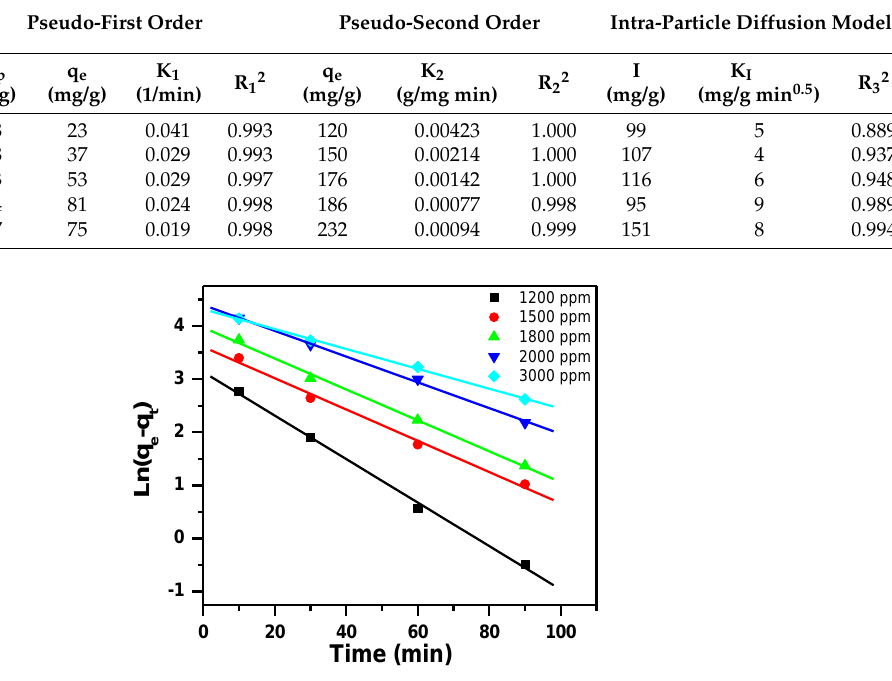
Figure 8. Pseudo-first order plot for the effect of initial dye concentration and contact time on removal of MB using